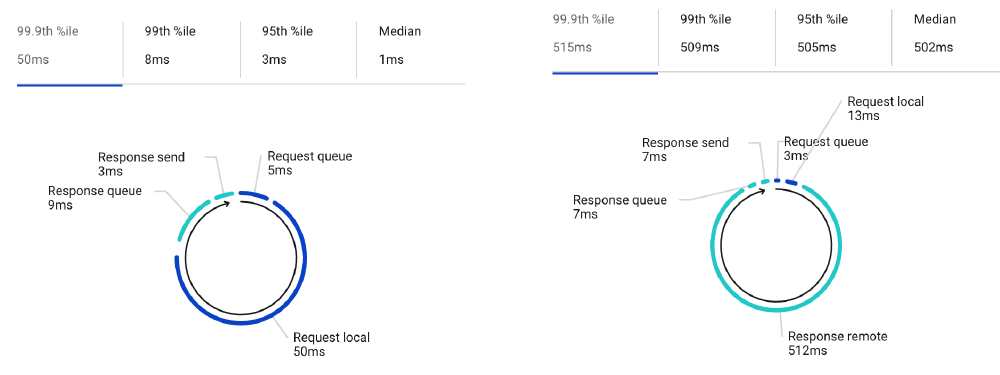
Figure 18. Performance evaluation simulation results of brokers in the